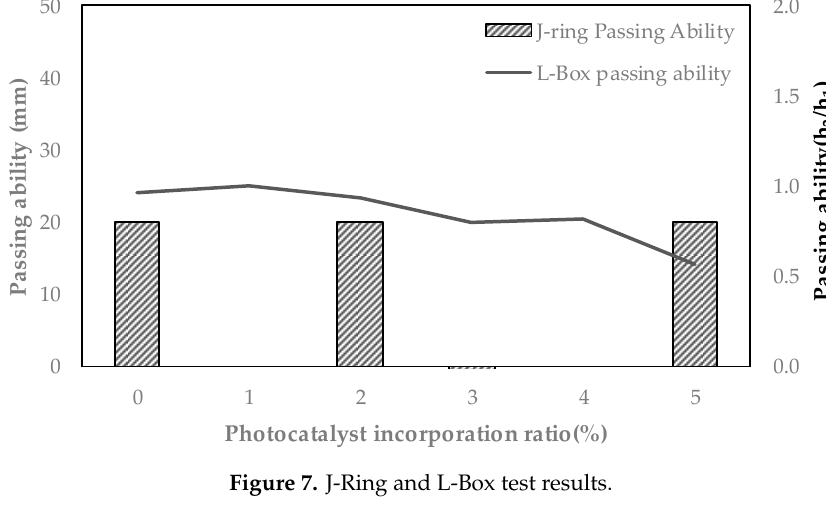
Figure 7. J-Ring and L-Box test results.